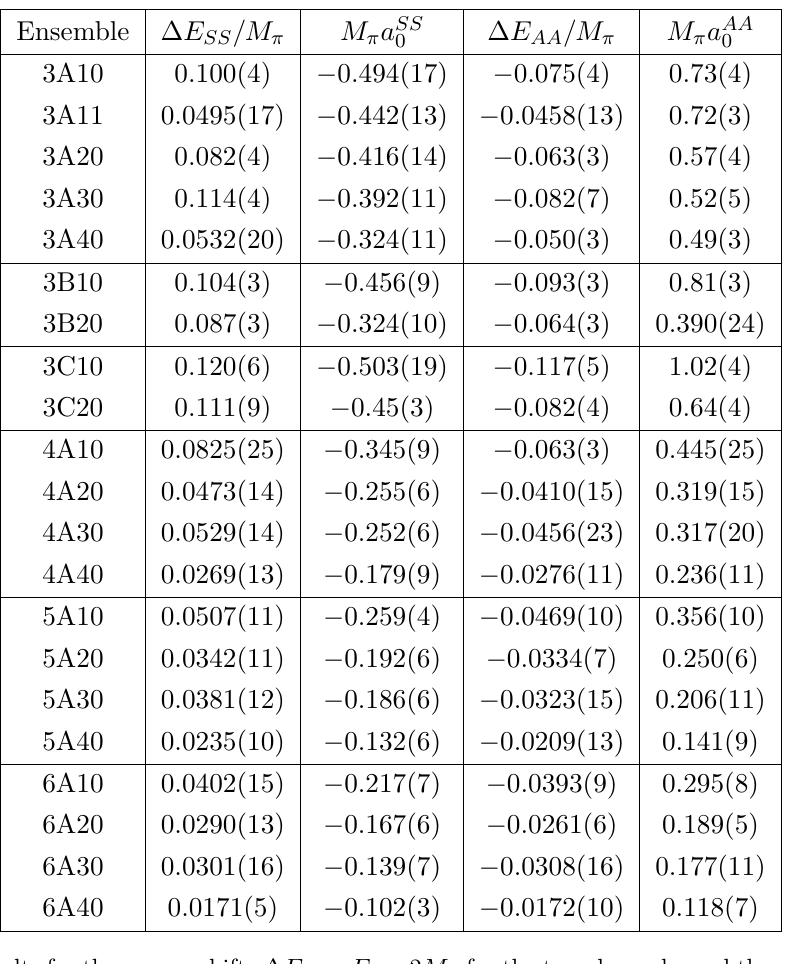
Table 4 . Results for the energy shifts ∆ E R = E R − 2 M π for the two channels, and the corresponding scattering lengths computed using eq. (3.4) to O ( L − 5 ) .